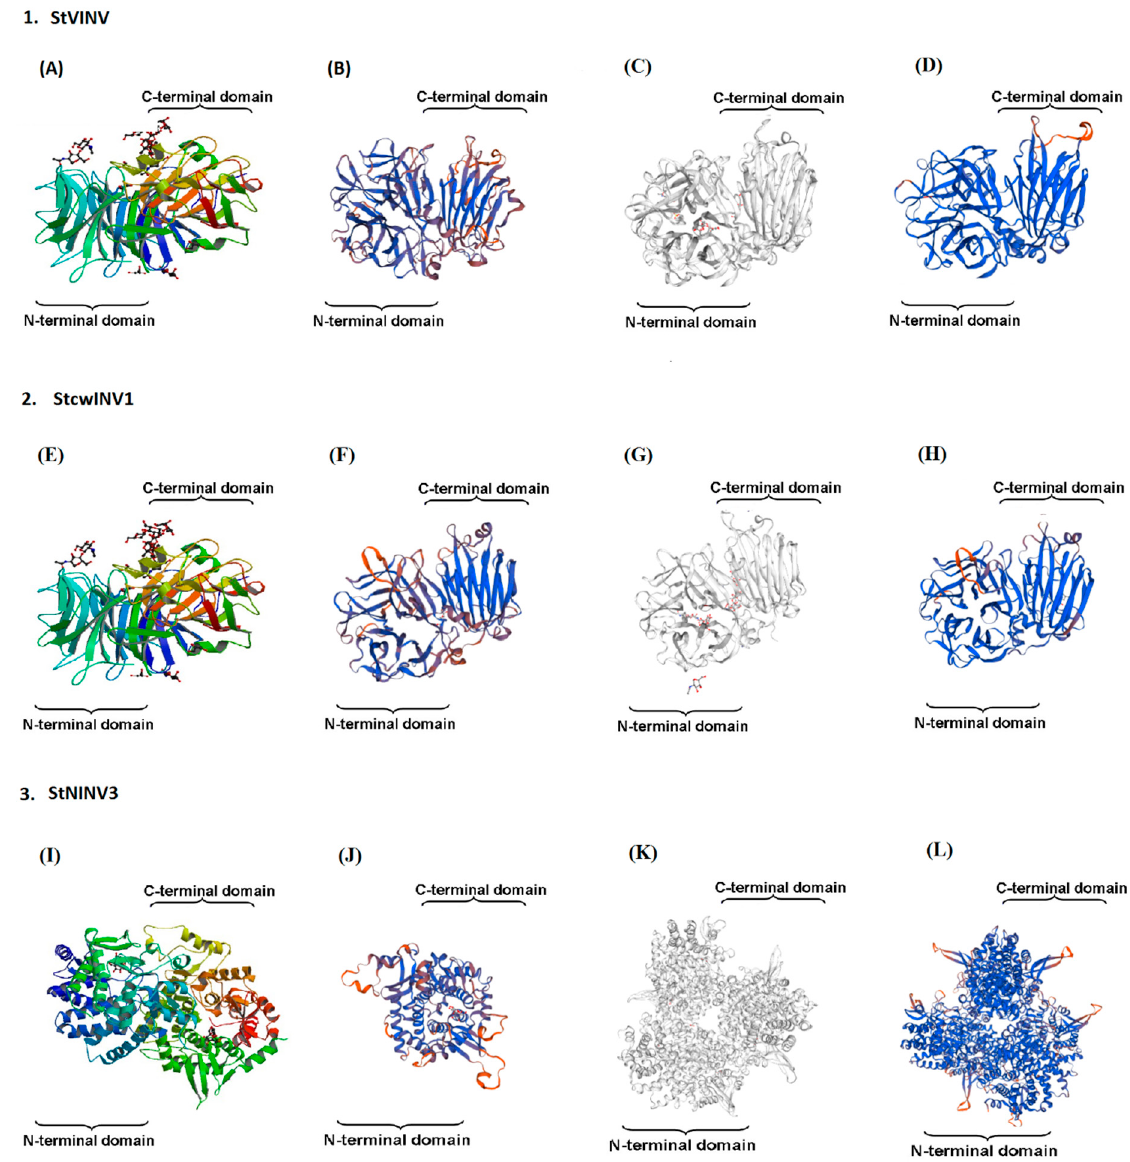
Figure 6. Predicted 3-dimensional structures of StVINV, StcwINV1, StNINV3. ( A ) AtCWINV1; ( B ) StVINV; ( C ) 6-fructosyltransferase; ( D ) StVINV; ( E ) AtCWINV1; ( F ) StcwINV1 ( G ) beta-fructofuranosidase; ( H ) StcwINV1; ( I ) AsInvB; ( J ) StNINV3 ( K ) AsInvA; ( L ) StNINV3. In the constructed 3D models bule color represents regions of high confidence and red color represents regions of low confidence.